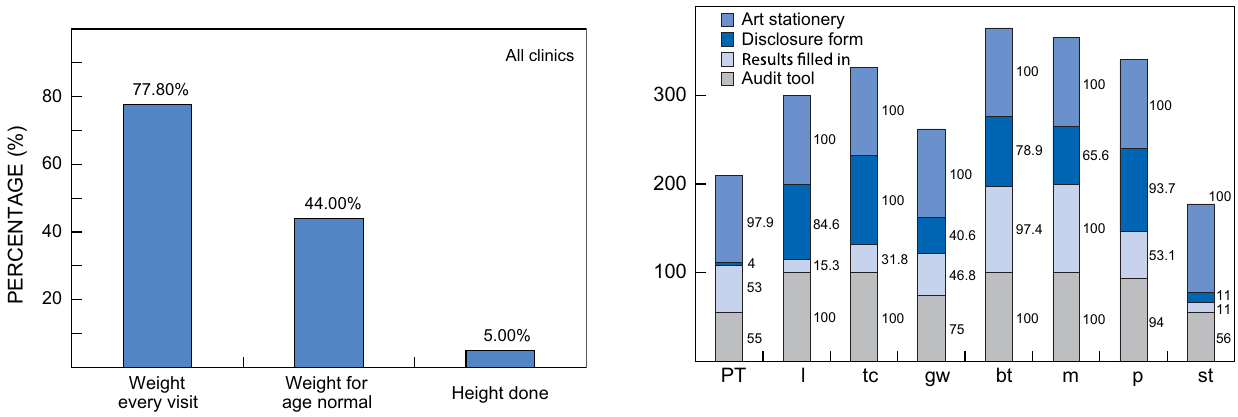
Figure 6: Availability of stationery in files in one